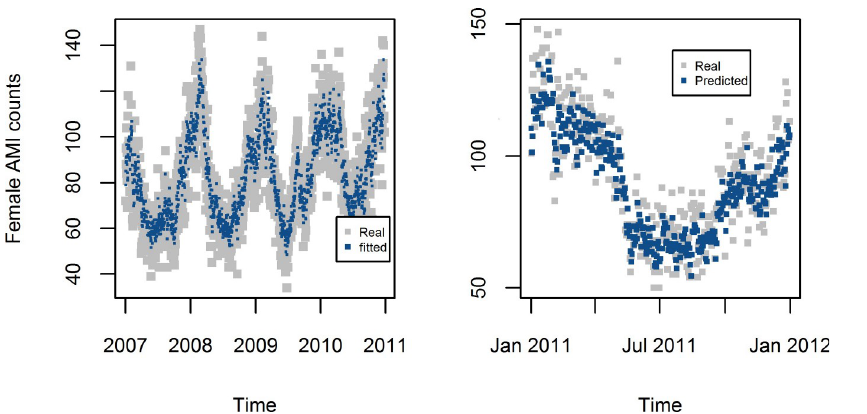
Fig 6. Estimated and forecasted daily counts of AMI from MGAM in Shanghai female residents aged 65+.